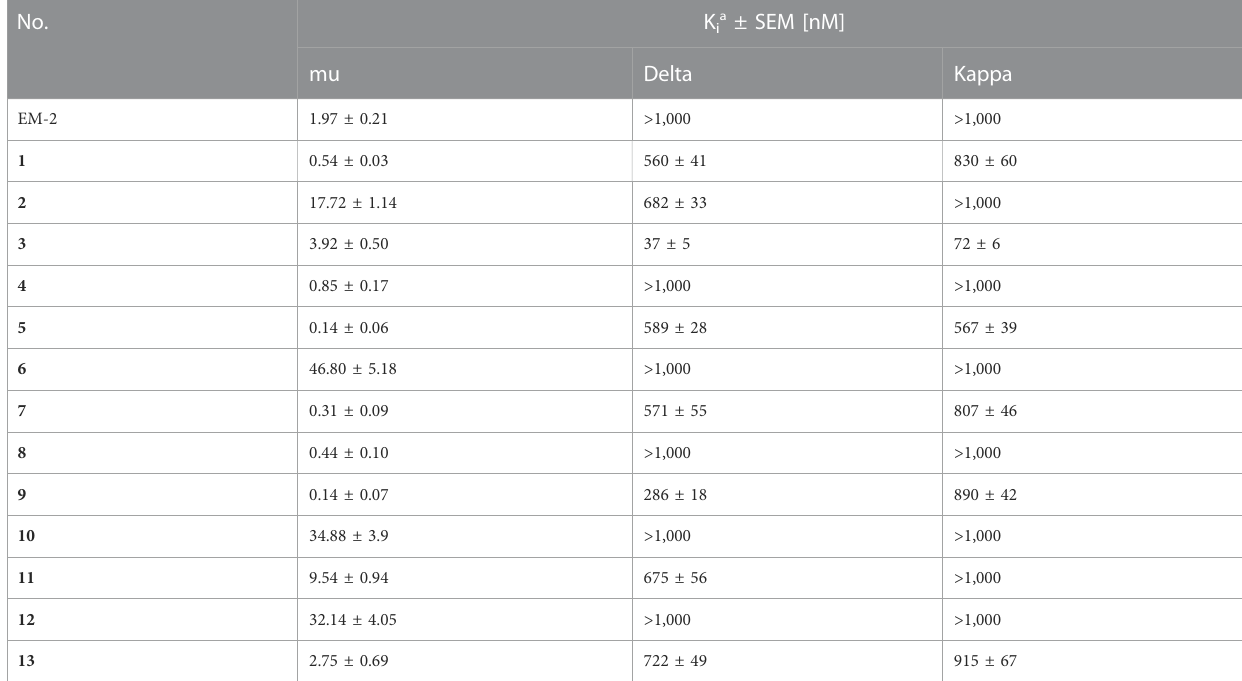
TABLE 2 Opioid receptor binding of EM-2